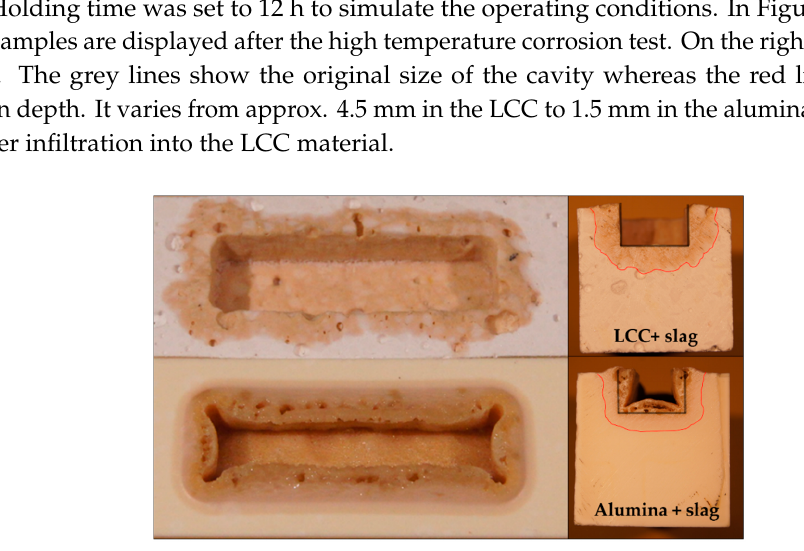
Figure 4. Comparison of the corroded area of the low cement castable (LCC) ( top ) and alumina ( bottom ) samples after corrosion test with slag.